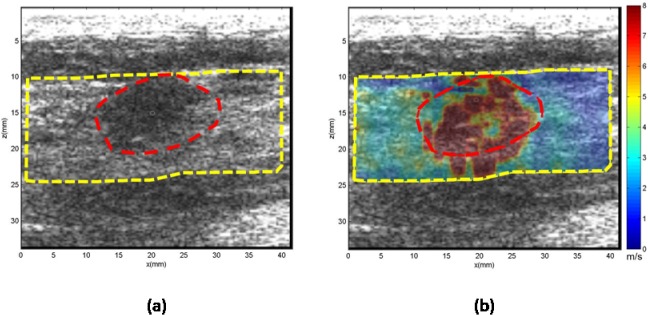
US and CUSE shear wave speed map of breast tissue (dashed yellow contour) including the breast mass ROI (red dashed contour).(a) B-mode US image. (b) CUSE shear wave speed map.